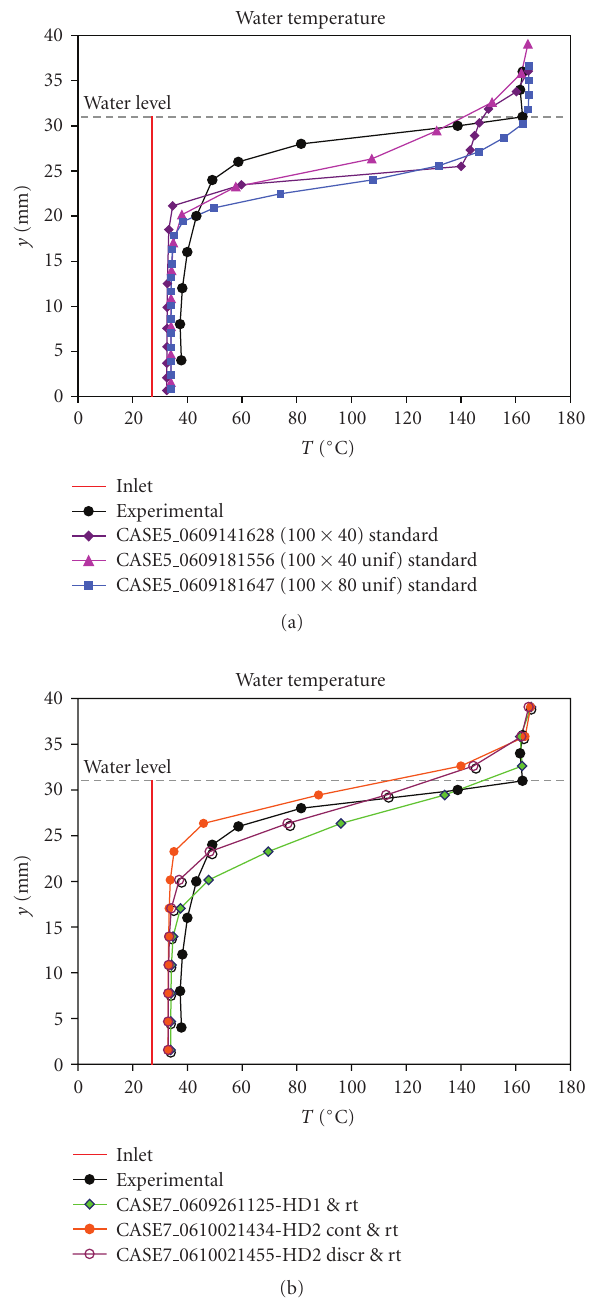
Figure 8: Water temperature profiles for (a) standard (“St”) and (b) modified condensation models (“cont” = continue approach, “rt” = relaxation time, “discr” = discrete approach).